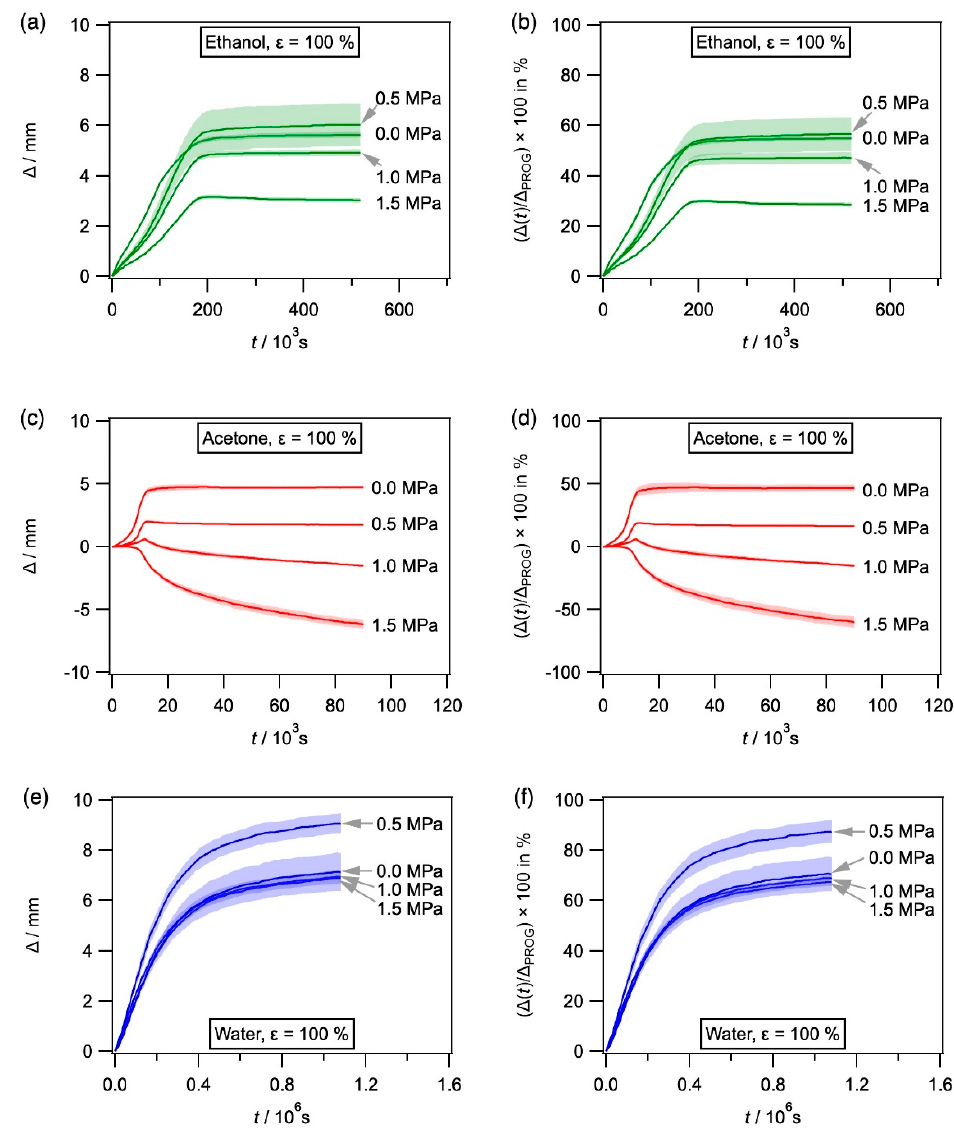
Figure 11. Evolution of ∆ with time for SMP-E specimens programmed to 100% and exposed to acetone, ethanol, and water (unconstrained and with varying end loads). ( a , b ) Exposure to ethanol. ( c , d ) Exposure to acetone. ( e , f ) Exposure to water. ( a , c , e ) ∆ in mm plotted as a function of time in s. ( b , d , f ) ( ∆ ( t )/ ∆ PROG ) × 100 in % vs. time in s.